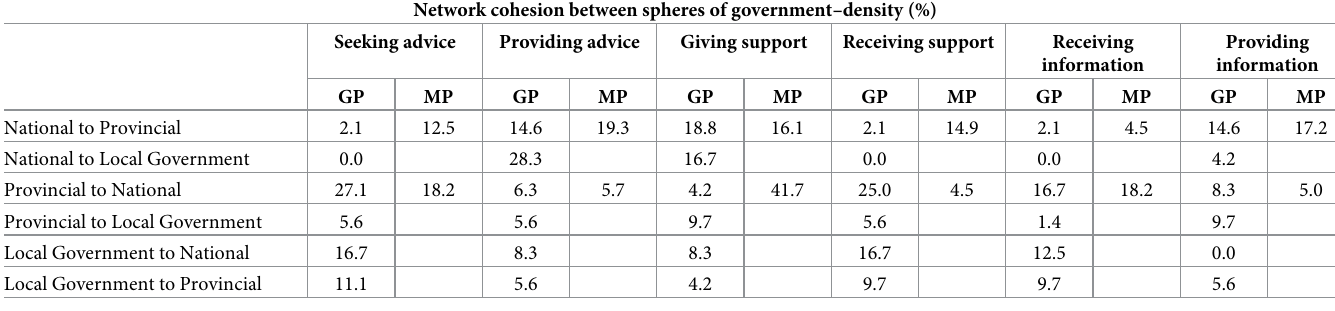
Table 4. Network cohesion between government spheres. Network cohesion between spheres of government–density (%) Seeking